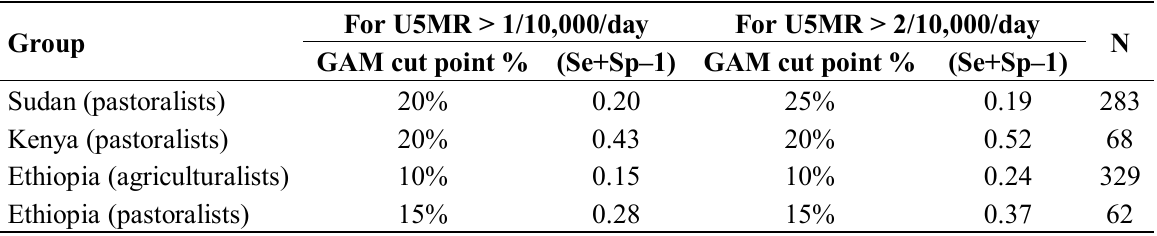
Table 5. GAM cut-points associated with best identification of elevated U5MR of 1 and 2/10,000/day, estimated by sum of sensitivity plus specificity (minus